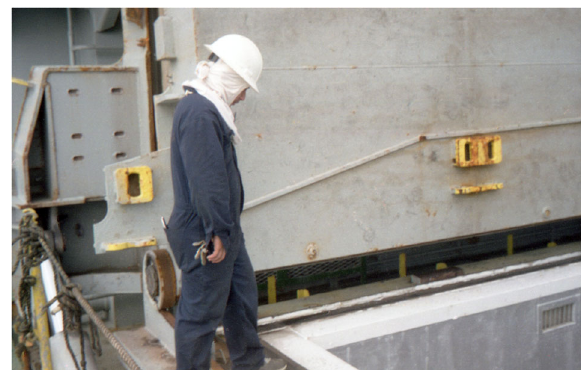
Fig. 5 Peering over the Edge. Photographs was taken by participants of seafarers working aboard the vessel while at sea.